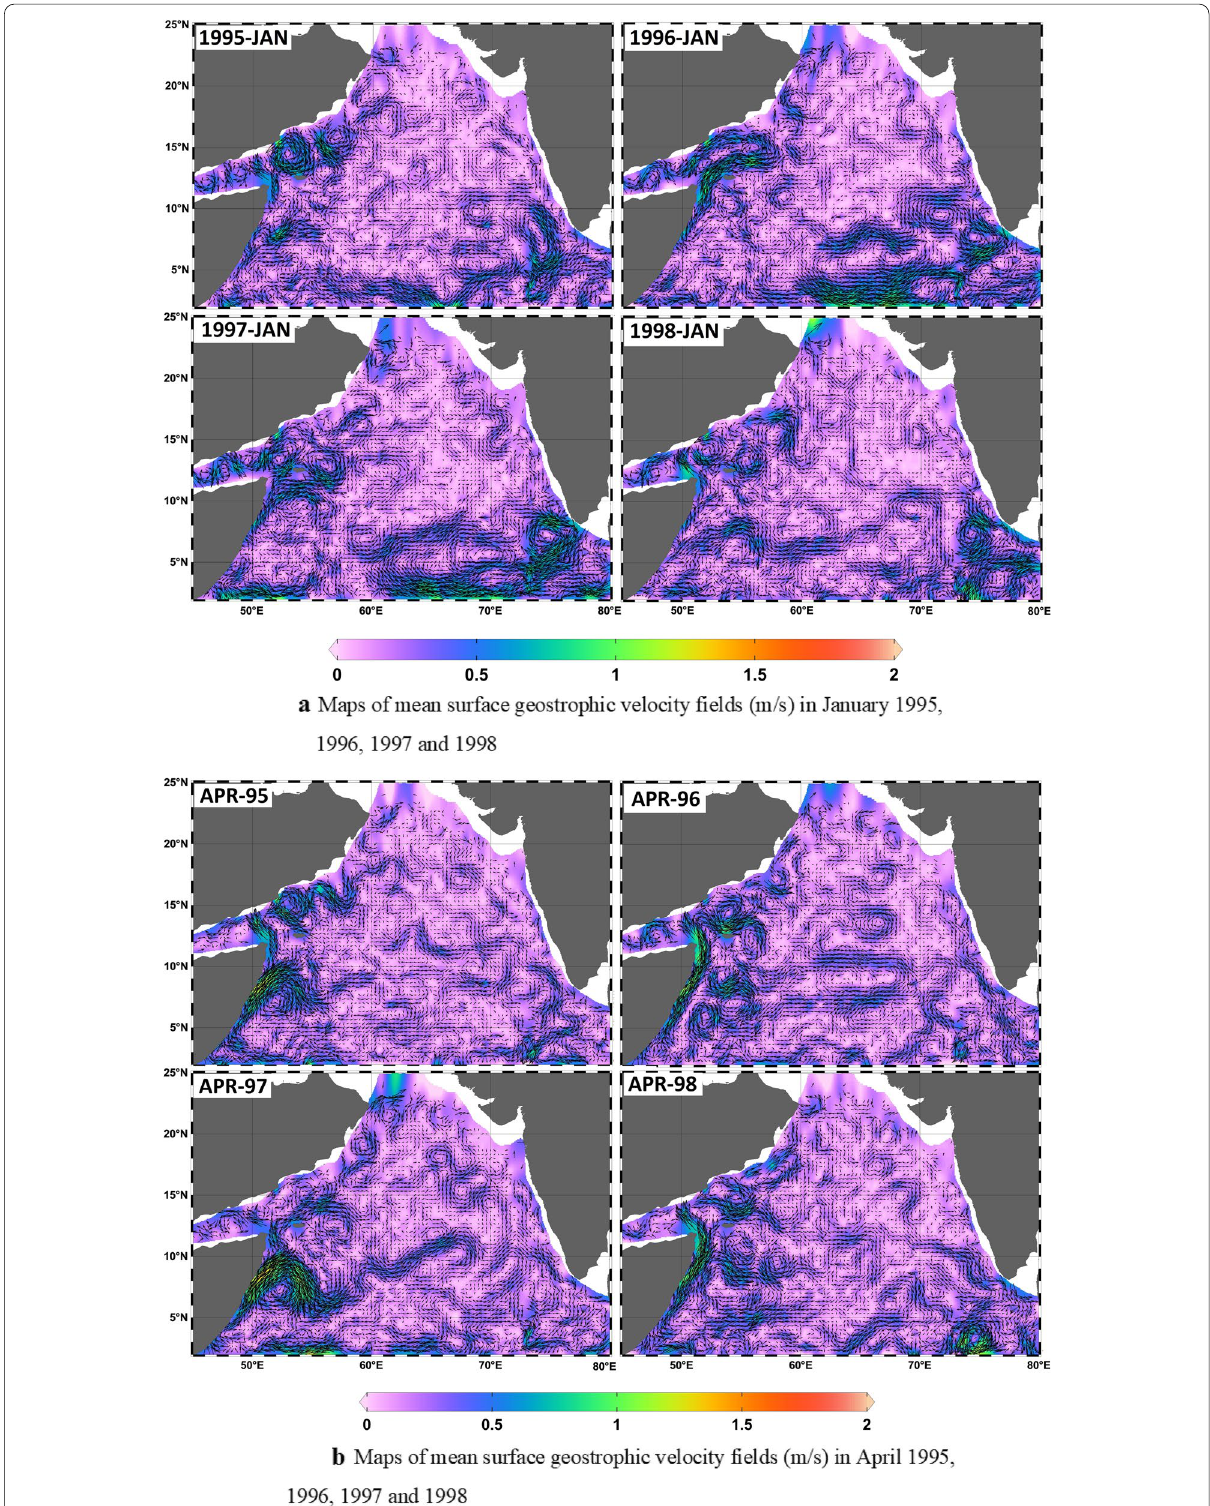
Fig. 8 a Maps of mean surface geostrophic velocity fields (m/s) in January 1995, 1996, 1997 and 1998. b Maps of mean surface geostrophic velocity fields (m/s) in April 1995, 1996, 1997 and 1998. c Maps of mean surface geostrophic velocity fields (m/s) in July 1995, 1996, 1997 and 1998. d Maps of mean surface geostrophic velocity fields (m/s) in October 1995, 1996, 1997 and